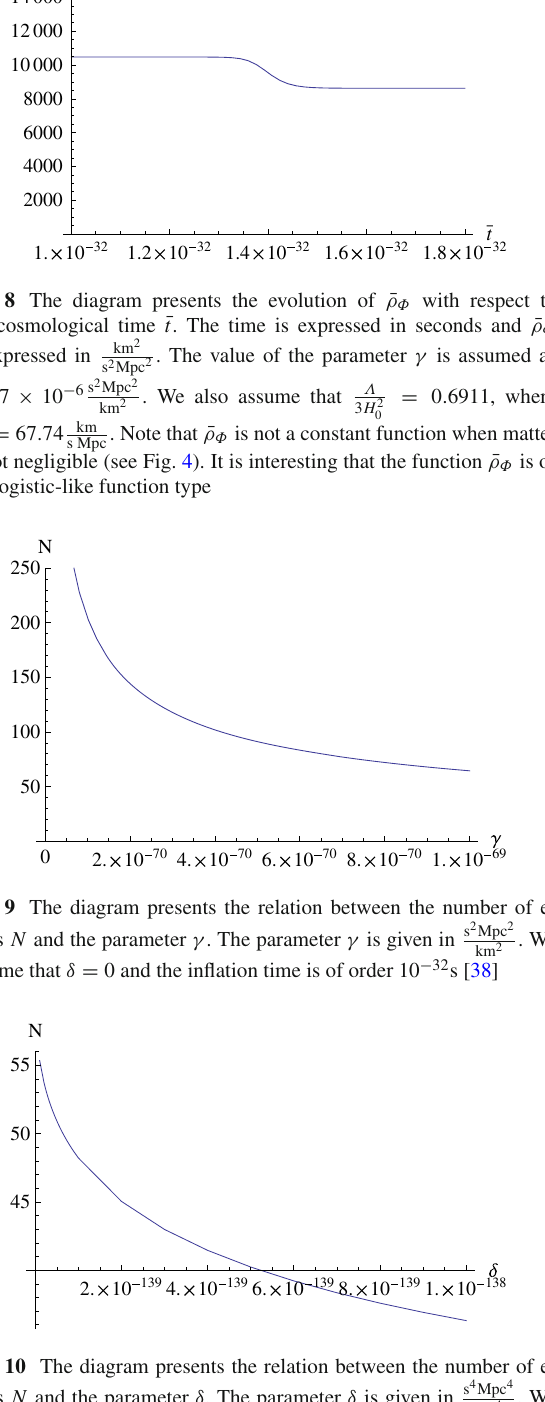
. We km 4 and the inflation time is of order km 2